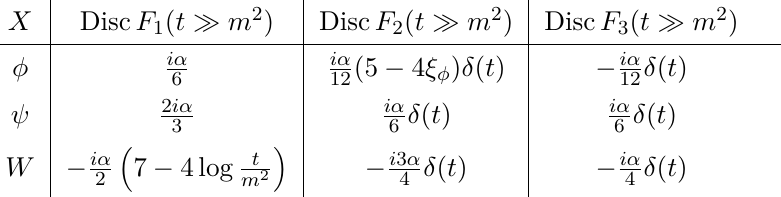
Table 2 . Limiting behavior of Disc F i in the kinematical region t < 0 and | t | /m 2 → ∞ . The Dirac’s delta functions signal that the concerned discontinuities vanish pointwise in the massless limit but not under